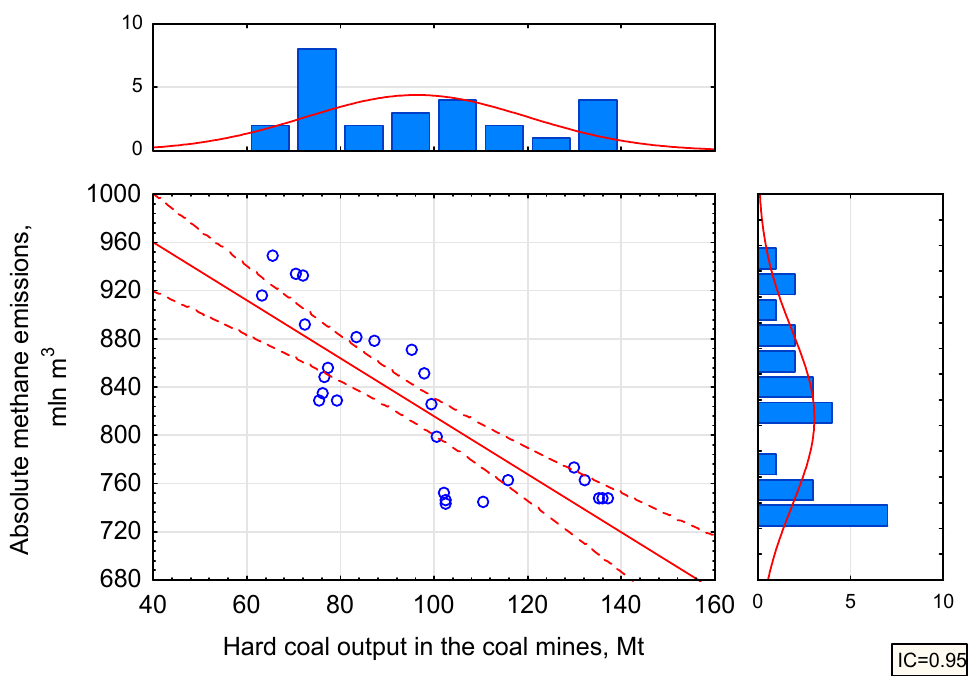
Figure 4. Relationship between hard coal output and absolute methane emissions in hard coal mines in Poland.